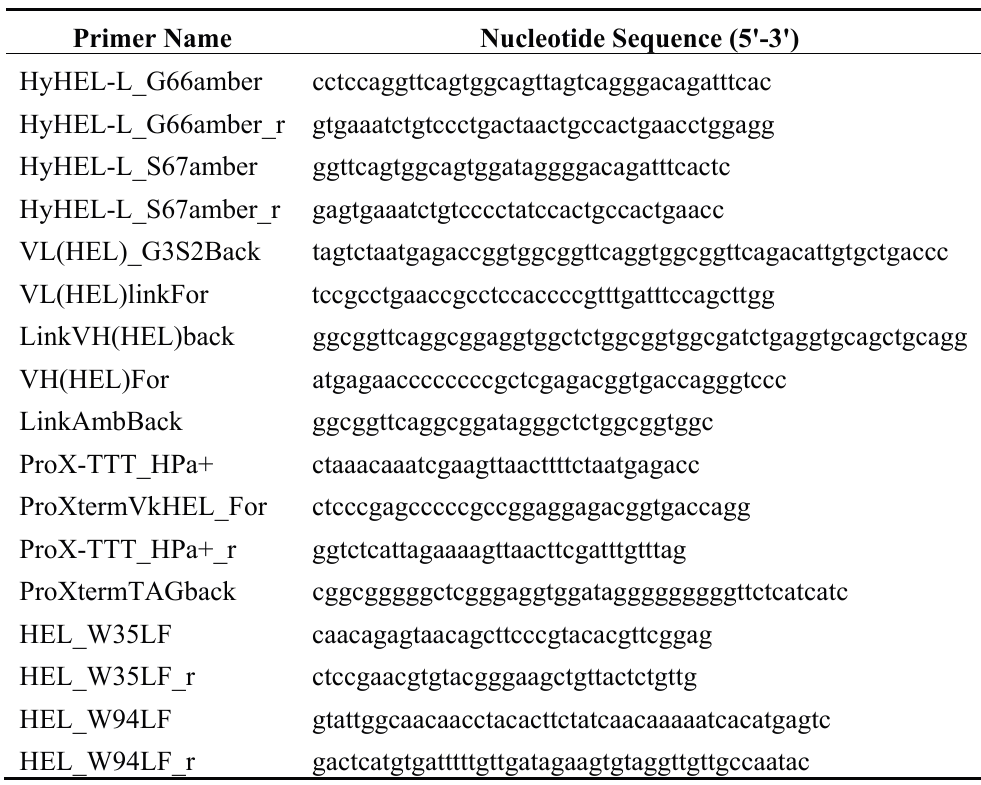
Table 2. Nucleotide sequences of the primers